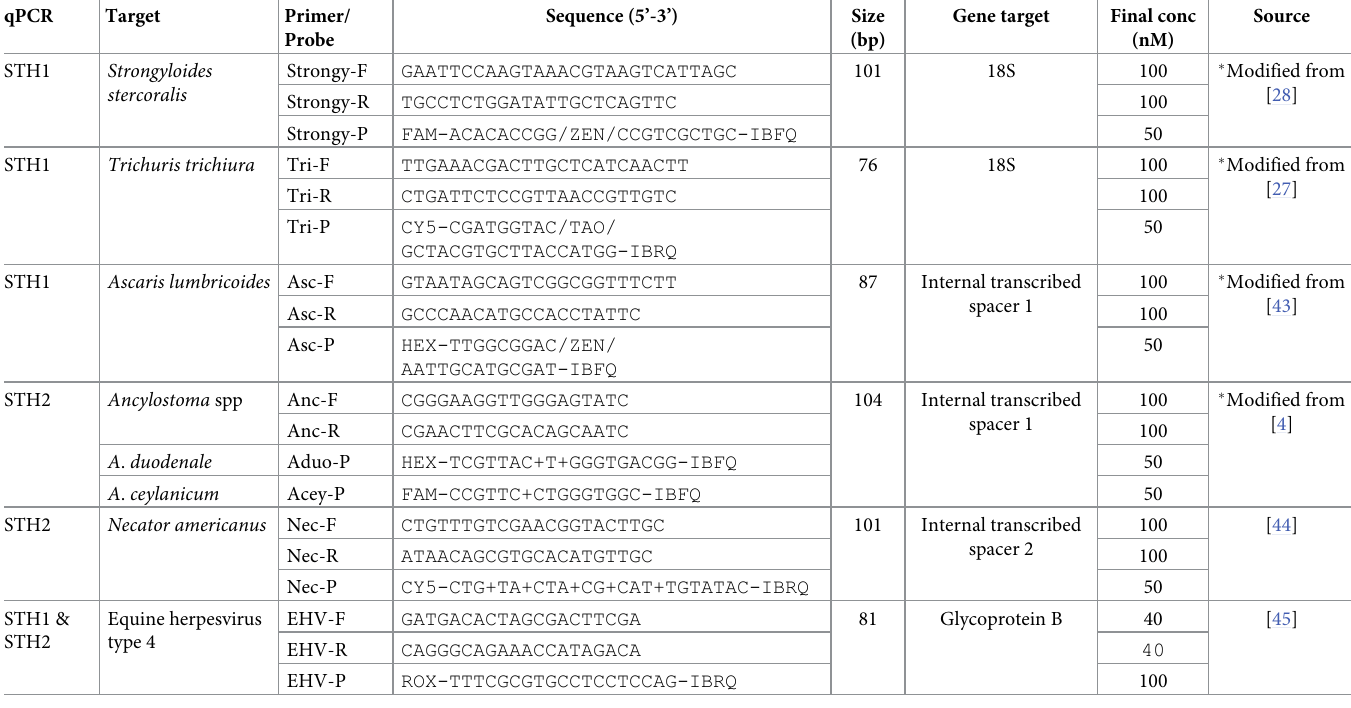
Table 1. The primers and probes used in the two multiplex reactions.